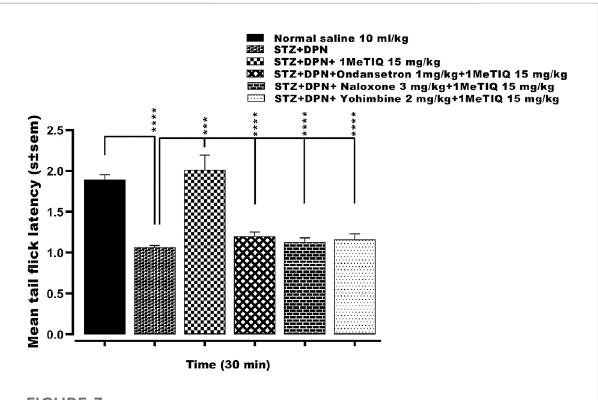
FIGURE 3 Effect of ondansetron, naloxone or yohimbine administration on the antihyperalgesic action induced by 1-Methyl-1, 2, 3, 4- tetrahydroisoquinoline (STZ + DPN+1MeTIQ 15 mg/kg) against streptozotocin-diabetic peripheral neuropathy (STZ + DPN) induced thermal hyperalgesia (Tail immersion test). Data are presented as mean ± SEM and the abscissa coordinate represents the tail fl ick latency 30 min after treatment. *** p < 0.001; **** p < 0.0001.